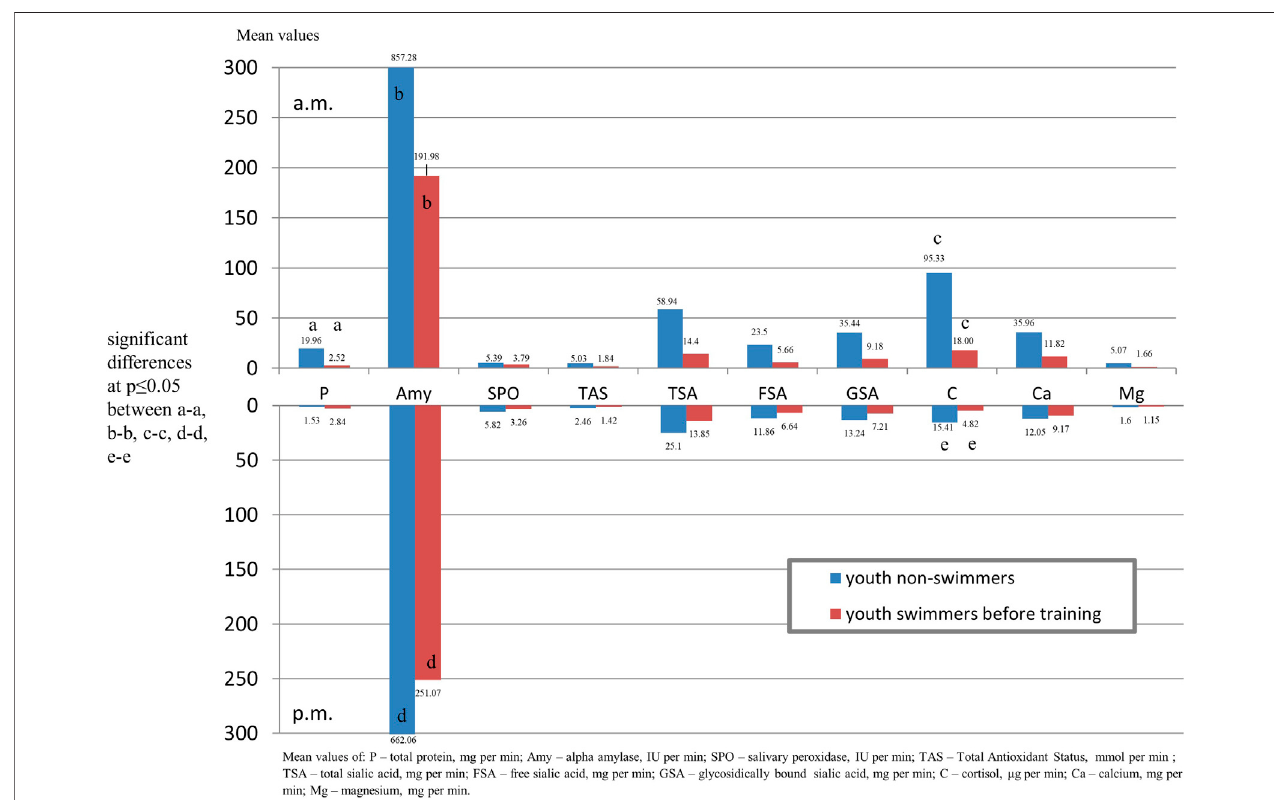
FIGURE 3 | Output of salivary components (mg/µg/U per min.) of youth swimmers before and after training in the morning and afternoon hours.